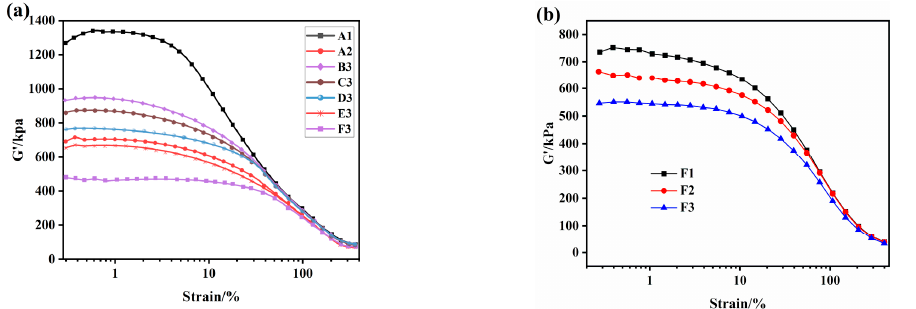
Figure 4. Strain amplitude dependence of the storage modulus (G’) of silica/SSBR/BR compounds:(a)samples with different ESSBRs(epoxy degree),(b) samples with different content of E25